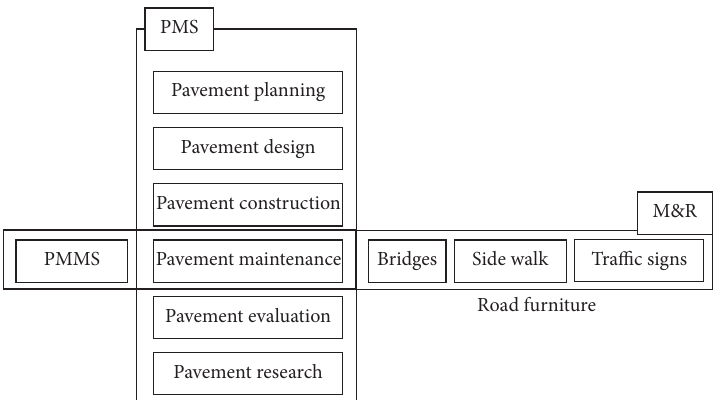
Figure 1: Schematic structure of a typical pavement management system (PMS) and pavement maintenance and management system